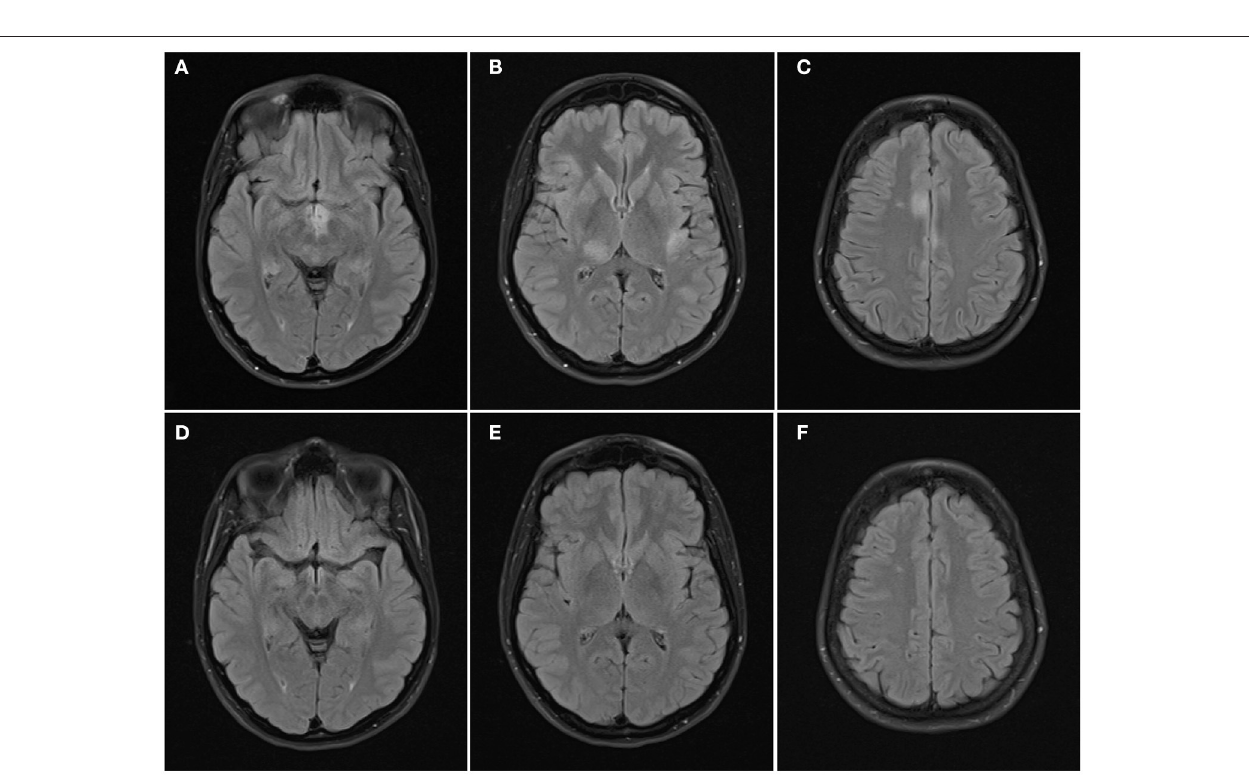
FIGURE 3 | Axial FLAIR images of the brain from the same patient across serial examinations. (A–C) At the time of disease presentation: FLAIR hyperintense lesions involve the hypothalamus and optic tracts (A) , right thalamus and left insular cortex (B) , and parasagittal frontal cortex bilaterally and right centrum semiovale (C) . (D–F) 5 months later: the lesions have all resolved except for the lesion in the right centrum semiovale.